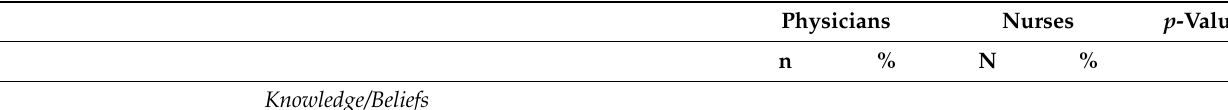
Table 4. Comparison between physicians and nurses regarding knowledge/beliefs related to palliative care.